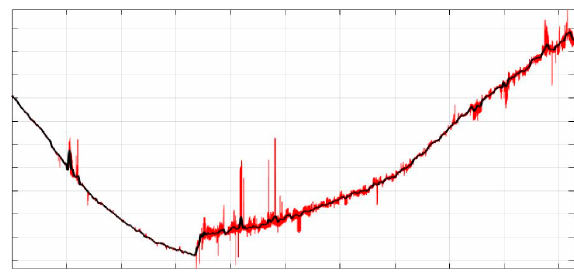
Figure 15. Z coordinate before and after denoising (red—original data, black—denoised data).